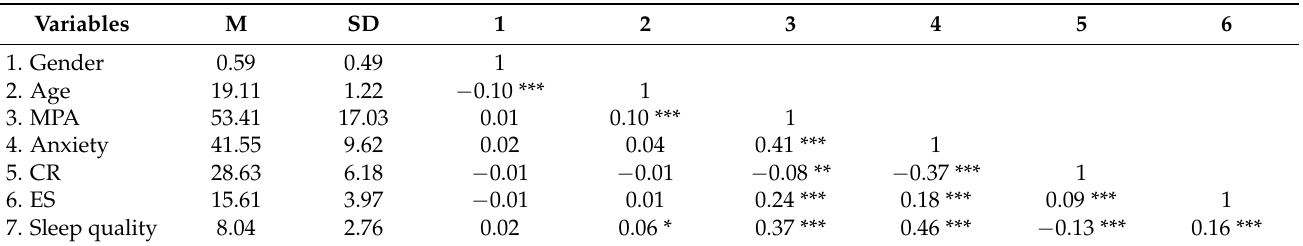
Table 1. Means, standard deviations and correlation analysis among study variables ( N = 1559).